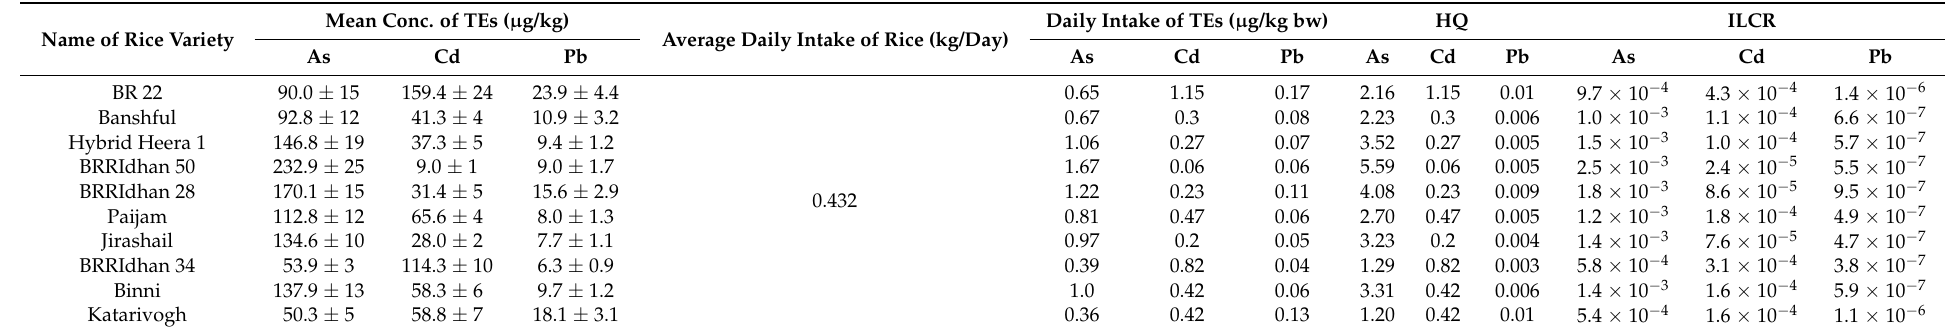
Table 4. Estimated daily intake of TEs (As, Cd, and Pb) from different brands of rice and the health risk for washing 3 times and a rice to water ratio of 1:2 (rice cooker methods of cooking).